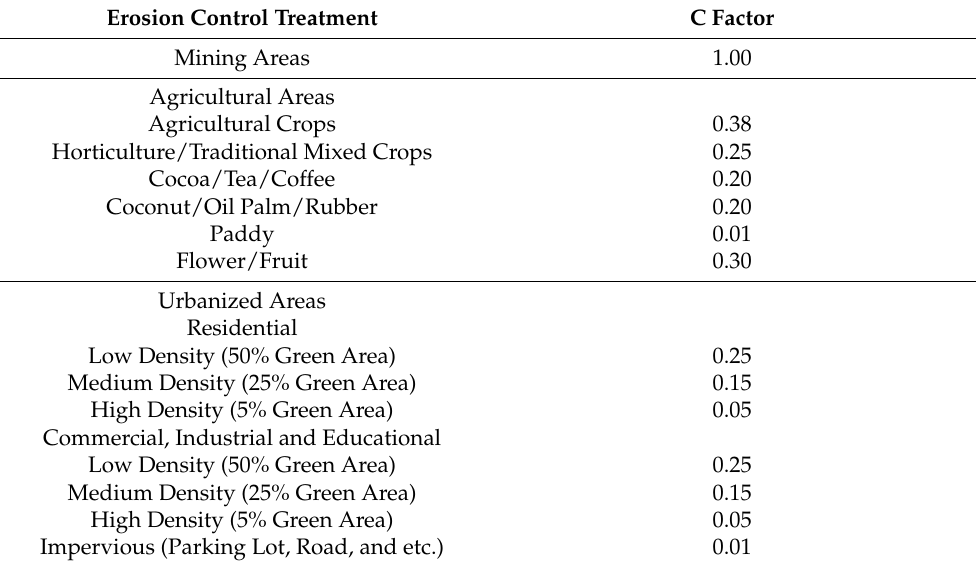
Table 2. Cover management, C factor, for agricultural and urbanized areas 1 [18,20]. Erosion Control